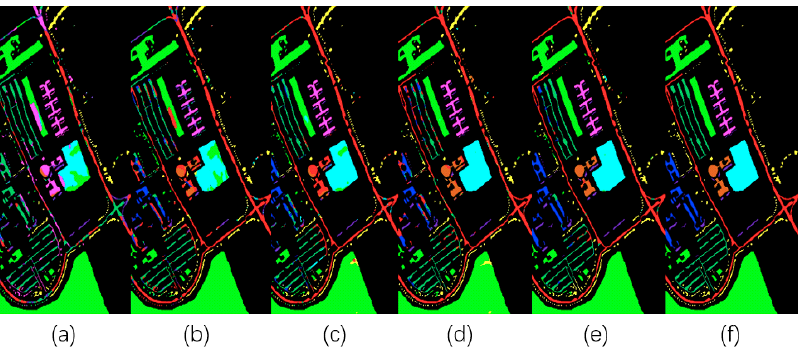
Figure 3. The predicted classification map for 0.5% samples from the Salinas dataset with the method of ( a ) 2D-CNN, ( b ) M3D-CNN, ( c ) HybridSN, ( d ) R-HybridSN, and ( e ) MSPN and ( f ) ground truth.